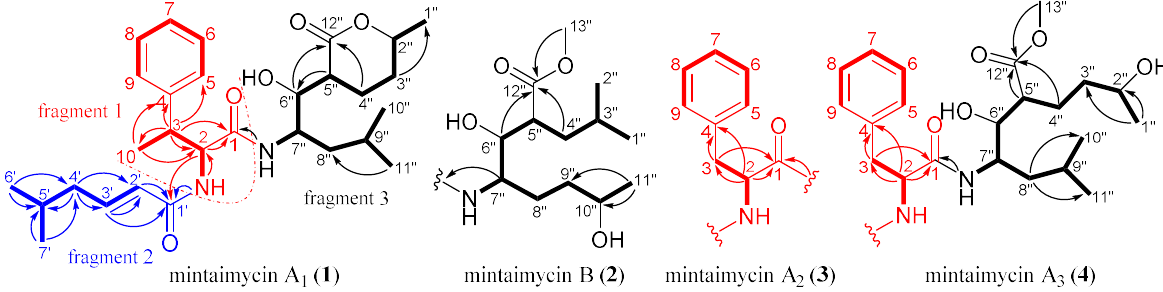
Figure 1. The 1 H- 1 H COSY (thick lines) and main HMBC (arrows) correlations of mintaimycins A 1–3 and B ( 1 – 4 ).